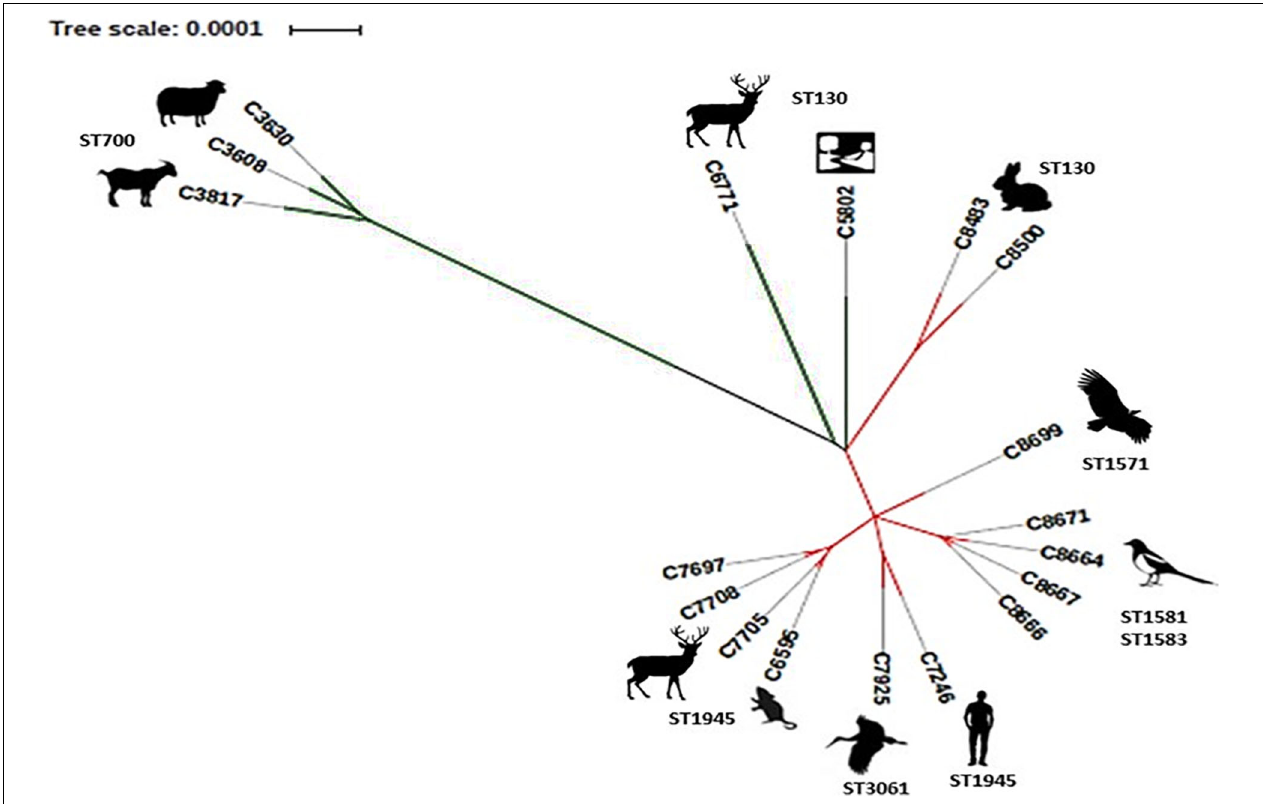
FIGURE 2 | Phylogenetic tree showing the phylogenetic distance between 18 strains CC130 included in this study. Green lines corresponding to MSSA and red lines to MRSA strains.